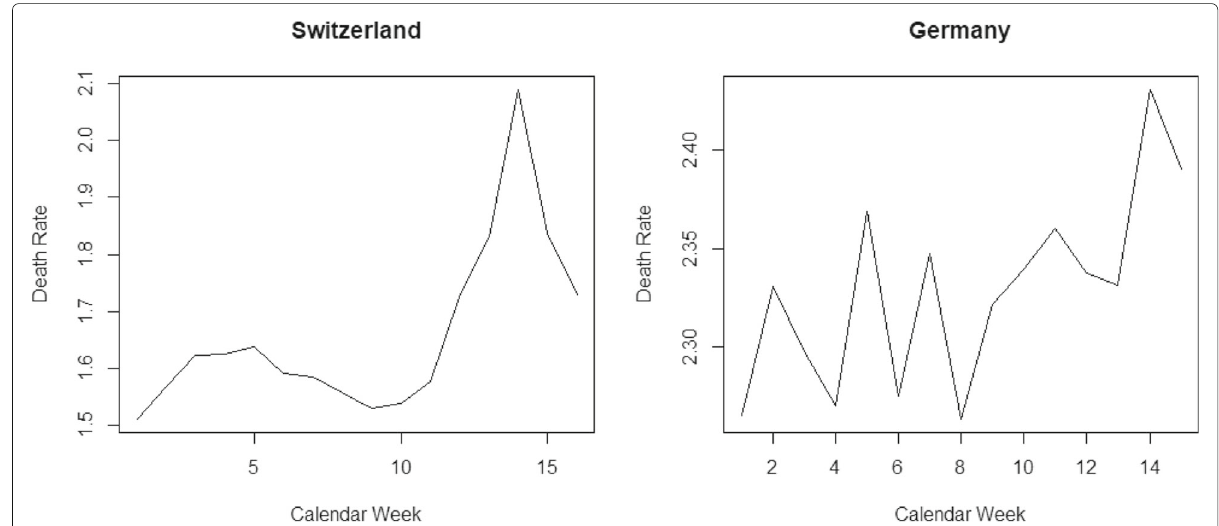
Fig. 2 Overall deaths per 10,000 inhabitants by calendar week in Switzerland (left) and Germany (right). Source: federal statistical offices of Switzerland (www.bfs.admin.ch) and Germany (www.destatis.de); retrieval date: May